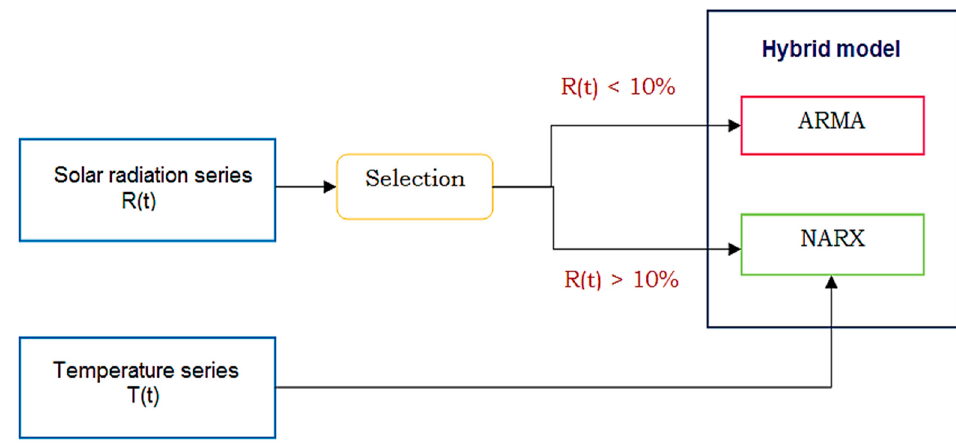
Figure 35. Proposed approach using a hybrid model (ARMA and NARX) .